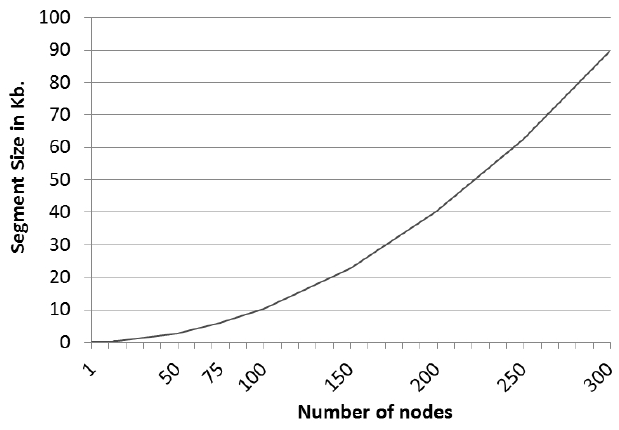
Figure 5. Segment size